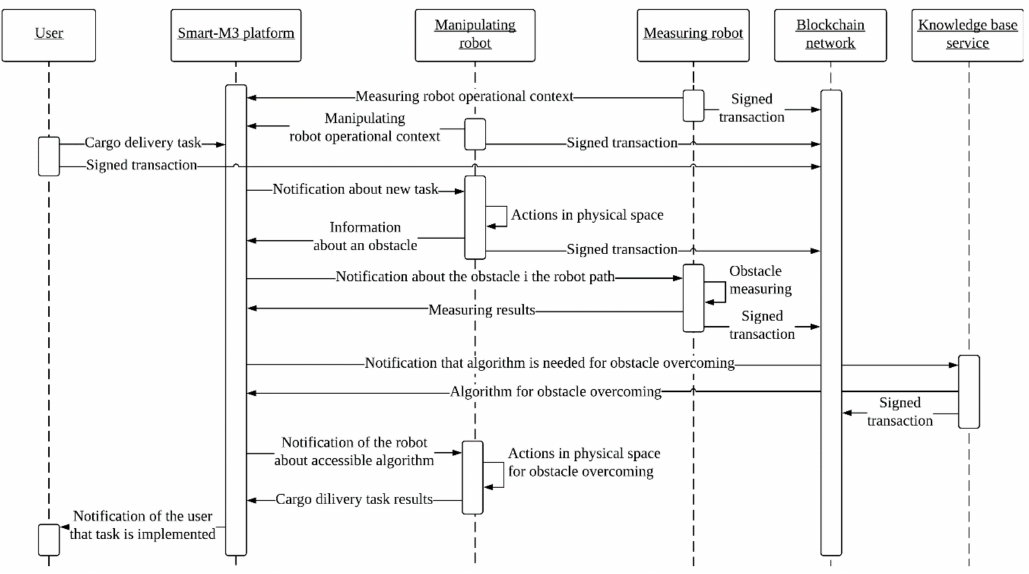
Figure 8. The scenario of heterogeneous robots collaboration work for obstacles overcoming.